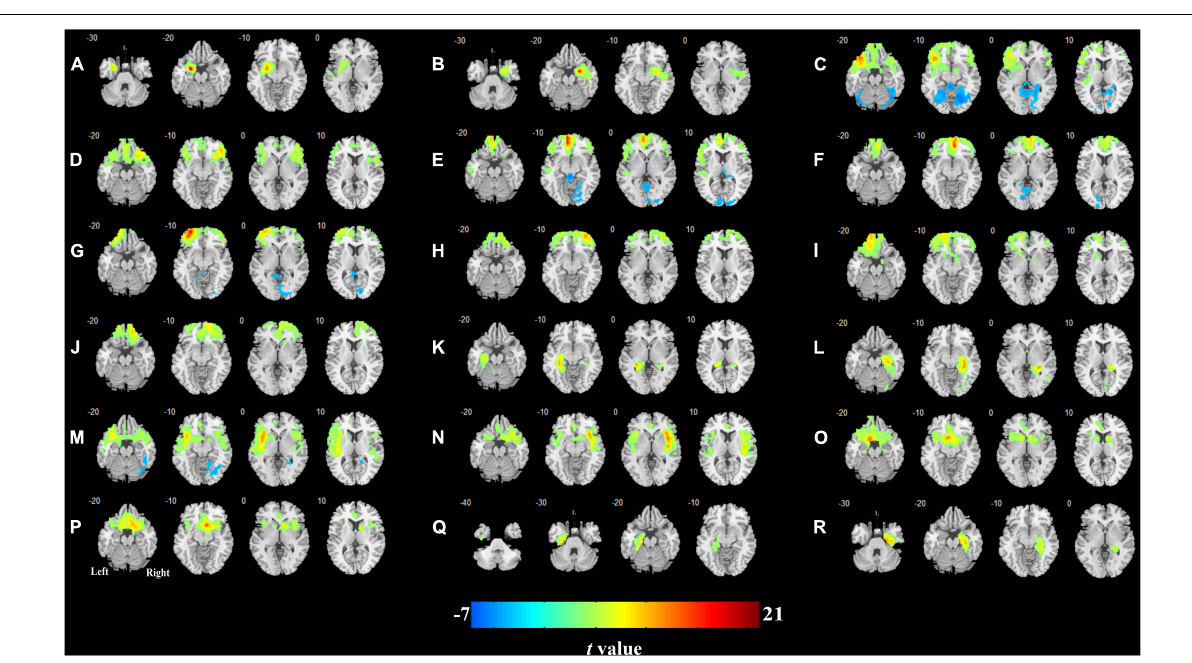
FIGURE 3 | Cerebral blood flow (CBF) connectivity patterns in olfactory-related brain regions in HCs. (A) Left amygdala; (B) right amygdala; (C) left orbital part of the inferior frontal gyrus; (D) right orbital part of the inferior frontal gyrus; (E) left medial orbital part of the superior frontal gyrus; (F) right medial orbital part of the superior frontal gyrus; (G) left orbital part of the middle frontal gyrus; (H) right orbital part of the middle frontal gyrus; (I) left orbital part of the superior frontal gyrus; (J) right orbital part of the superior frontal gyrus; (K) left hippocampus; (L) right hippocampus; (M) left insula; (N) right insula; (O) left olfactory cortex; (P) right olfactory cortex; (Q) left parahippocampal gyrus; (R) right parahippocampal